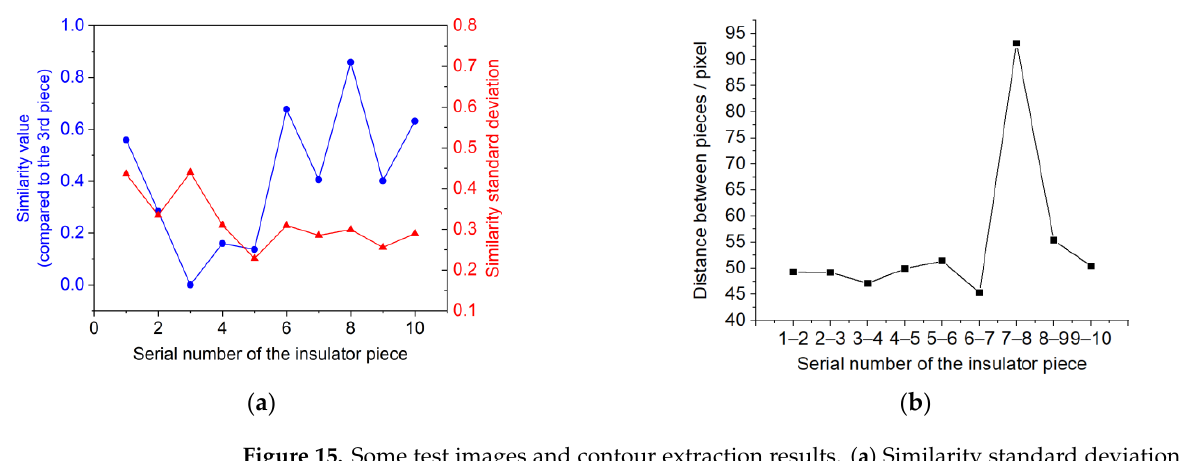
Figure 14. Insulator with large damage range and its contour extraction results.